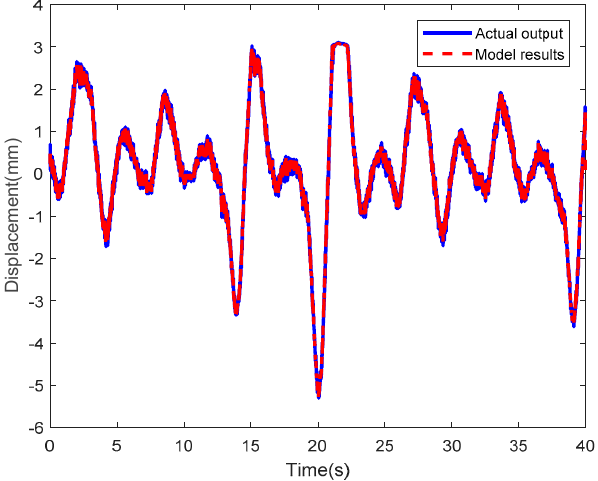
Figure 35. Results of the optimized LSSVM ‐ NARX model at random sinusoidal actuating voltage I.